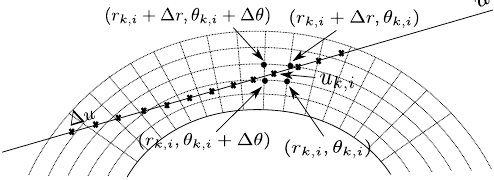
Figure 5. Computation of the integral